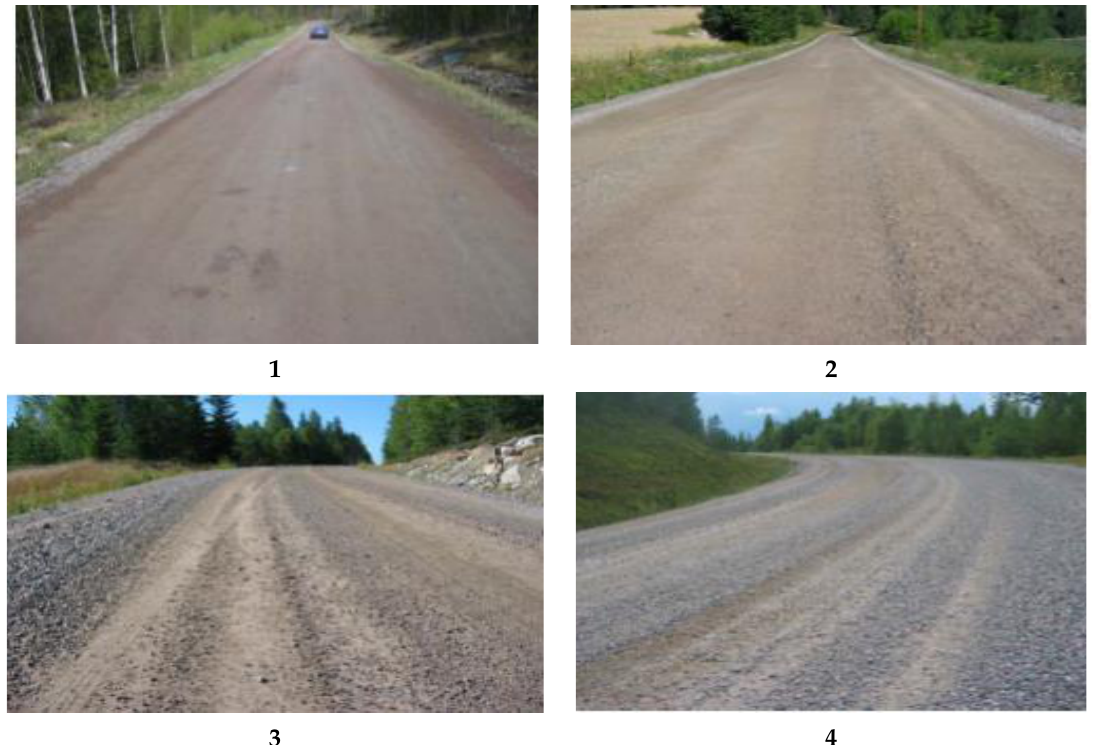
Figure 1. Example images of gravel roads for the Swedish gravel road assessment manual defined by Trafikverket showing the severity level for loose gravel: from 1 “good condition” roads to 4 “worst condition” roads. These images provide a guideline/ground truth for the experts to compare real-time images with these standard images and assign a rating to a particular road under observation. Maintenance plans are decided according to these ratings for each road. Detailed descriptions of each road type are defined in Table 1 [19]. Table 1. In addition to images, some text descriptions are laid in the manual for the Swedish gravel road assessment method explaining each severity level to aid experts in deciding on a certain road condition [19].